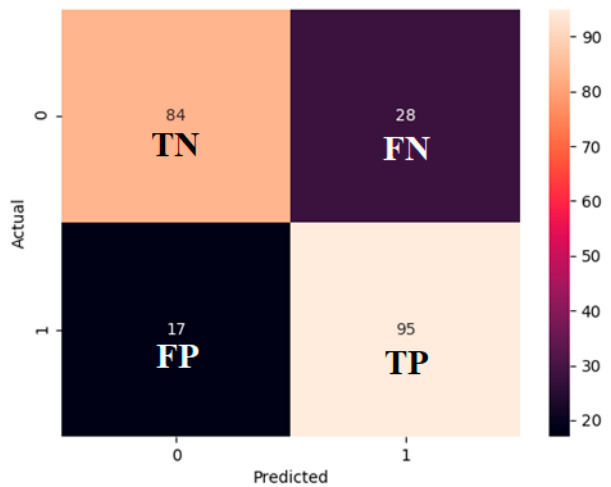
Figure 11. A confusion matrix showing the prediction accuracy of a classifier for two or more classes. The classifier’s predictions are on the X-axis and the result (accuracy) is on the Y-axis. TP is a true positive decision; we predicted we found a weed and it was a weed. FP is a false positive decision; we predicted it was a weed, but it was not a weed. FN is a false negative decision; we predicted it was not tomato and it was not true. TN is a true negative decision; we predicted that this is not a tomato and it was true.